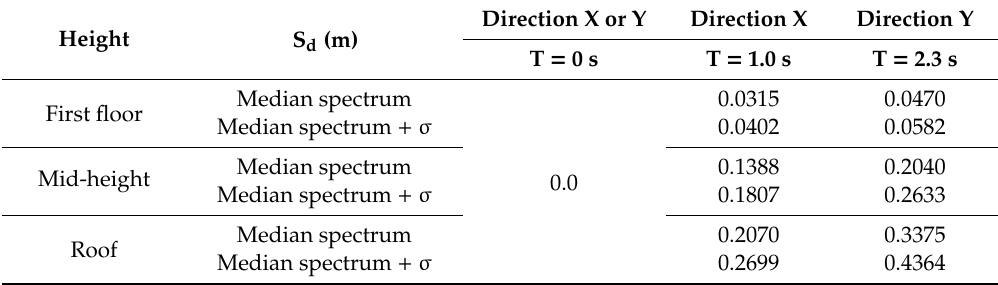
Table 3. Spectral relative displacement values for RP = 140 years for three periods of interest.